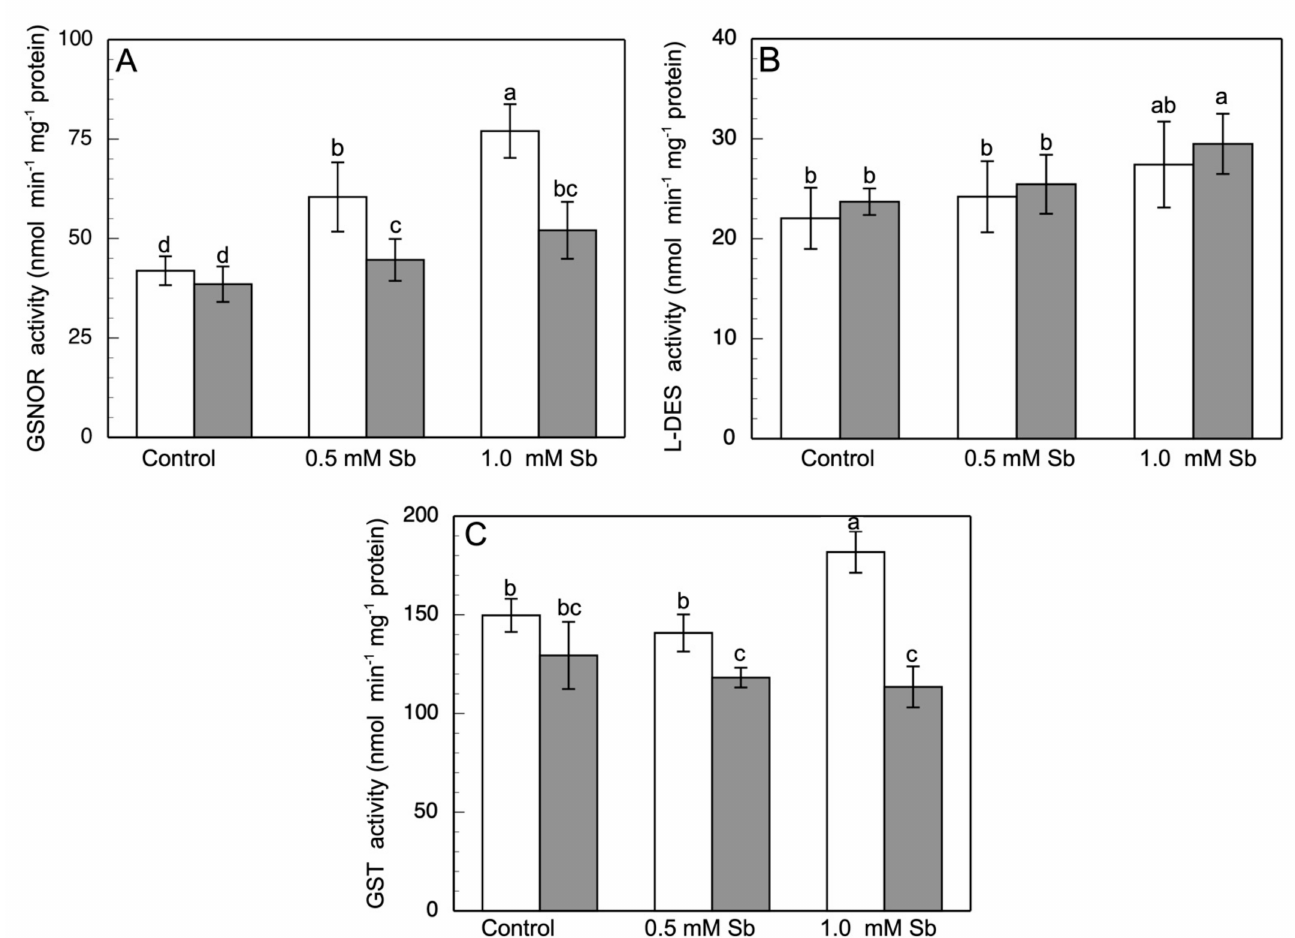
Figure 5. Effect of Sb on the GSNOR ( A ), L-DES ( B ) and GST ( C ) activities in roots (white) and leaves (gray) of D. viscosa . The data are from 10 independent experiments, each carried out in triplicate (different letters indicate significant differences at p < 0.05, Mann–Whitney